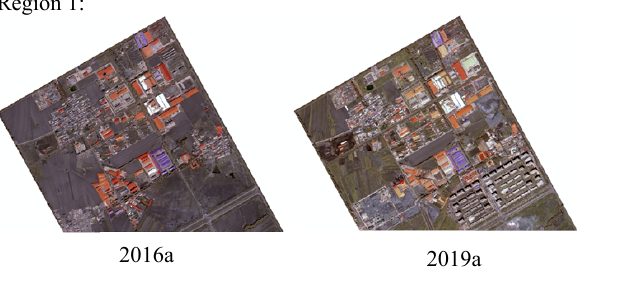
Figure 1. Selected Area 1